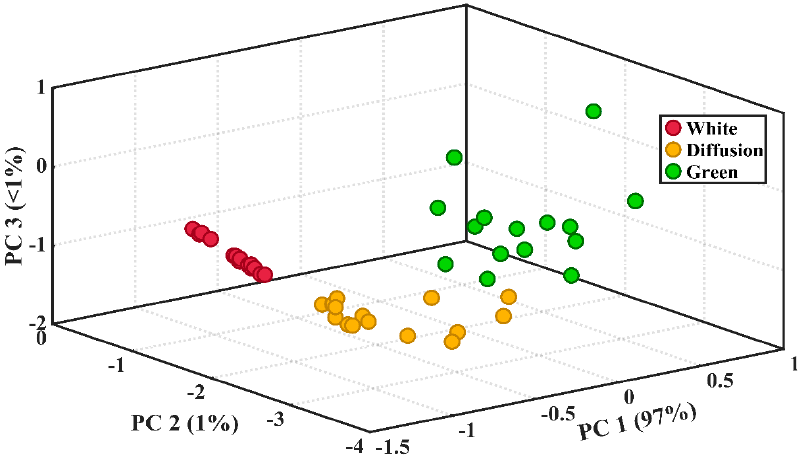
Figure 11. PCA score plot of the sample applied to the wavelength region of CaF molecular band (530–630 nm) demonstrating 99% of total variance.